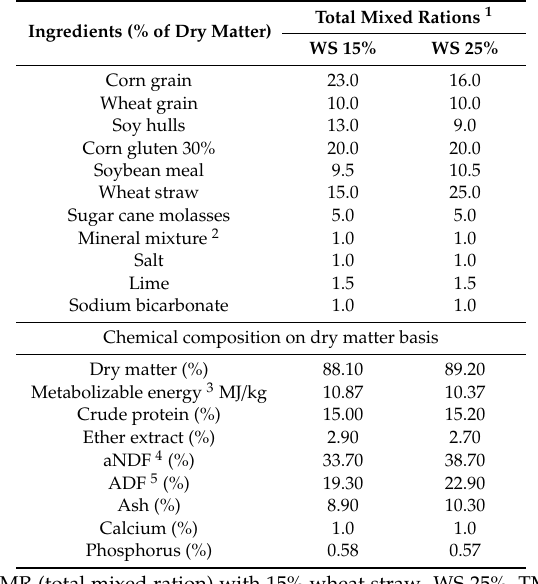
Table 1. Inclusion level of ingredients and chemical composition of conventional and pelleted total mixed rations (TMRs) used in the fattening